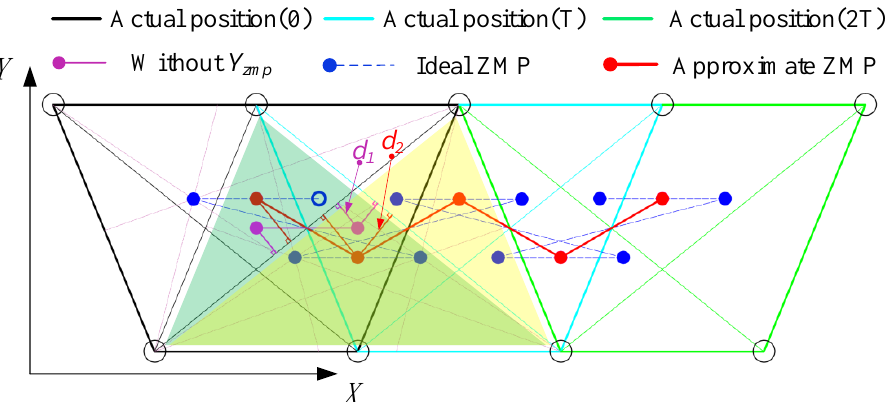
Figure 7. Evolution process of the ZMP trajectory. Black, cyan and green lines represent the support polygons of the quadruped robots at 0, T and 2T,